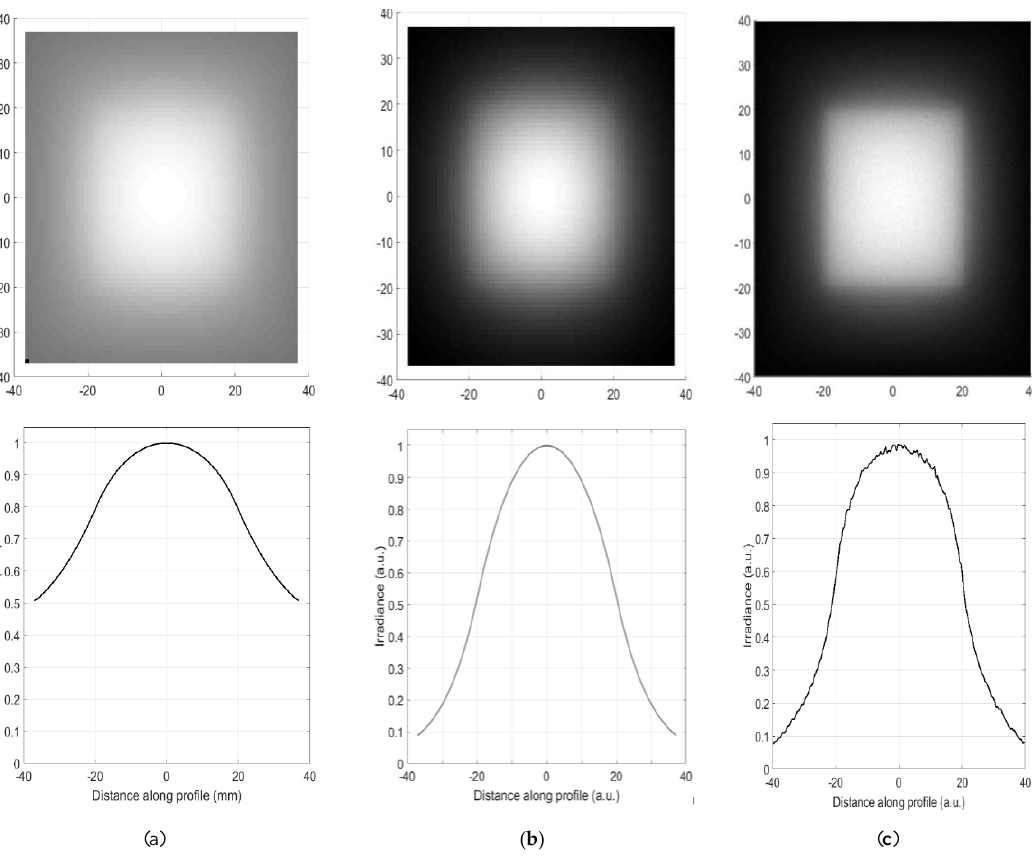
Figure 14. Irradiance pattern and central irradiance profile at the detector for the reflective system with the detector located at z = 550 mm: ( a ) computed by flowline vector potential method; ( b ) computed by OPL correction in flowline vector potential method; ( c ) computed by raytrace.